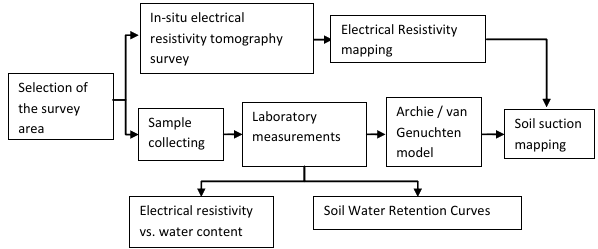
Fig. 1. Schematic diagram of the proposed procedure for carrying out soil suction mapping.